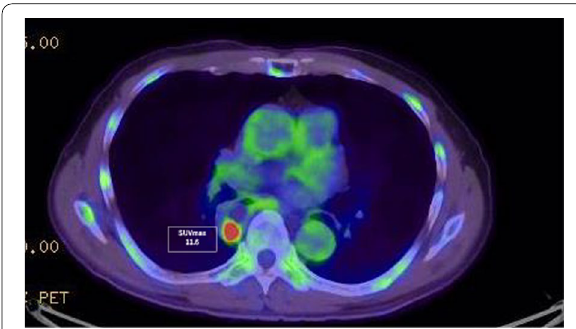
Fig. 3 Positron emission tomography–computed tomography image showing fluorodeoxyglucose accumulation in the middle thoracic